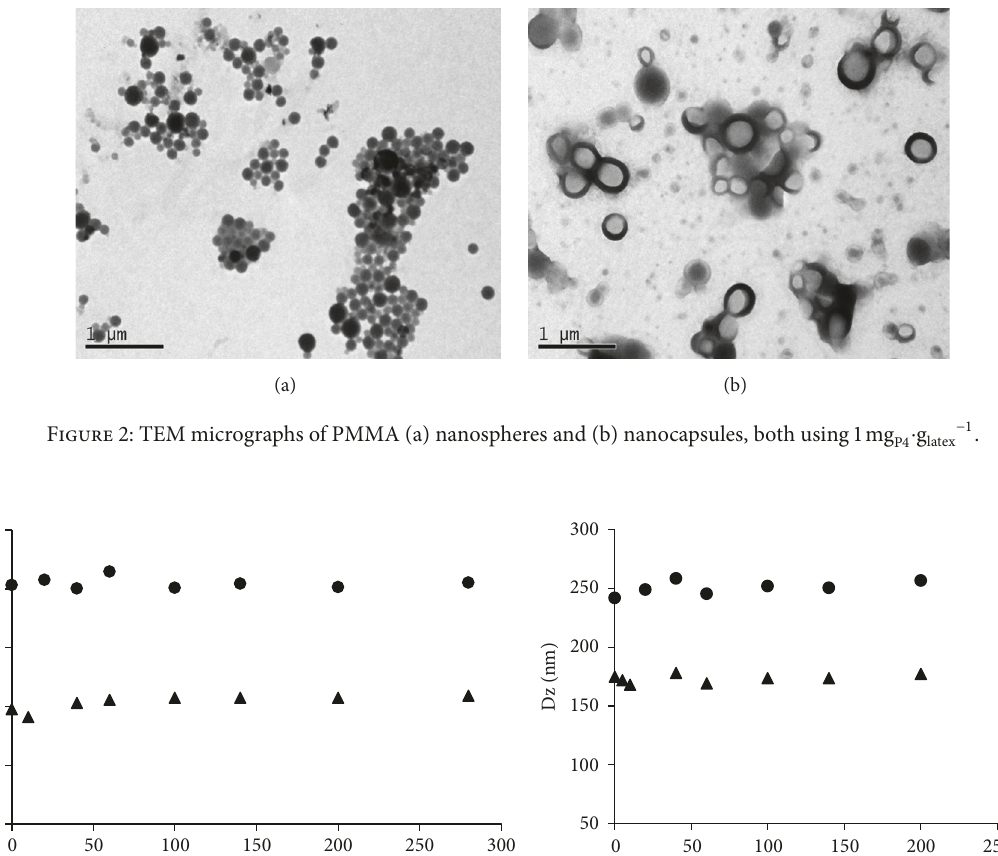
−1 ) (b). NC (nanocapsules) and NS (nanospheres). ⋅ g latex P 4